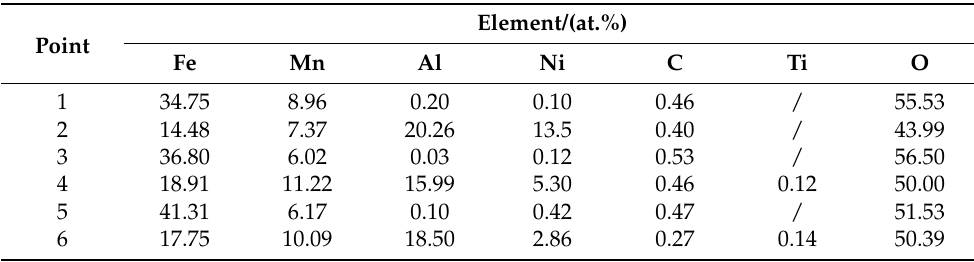
Table 5. EDS analysis of longitudinal cross-sections of Fe-25Mn-9Al-8Ni-1C-xTi alloy oxidized for 200